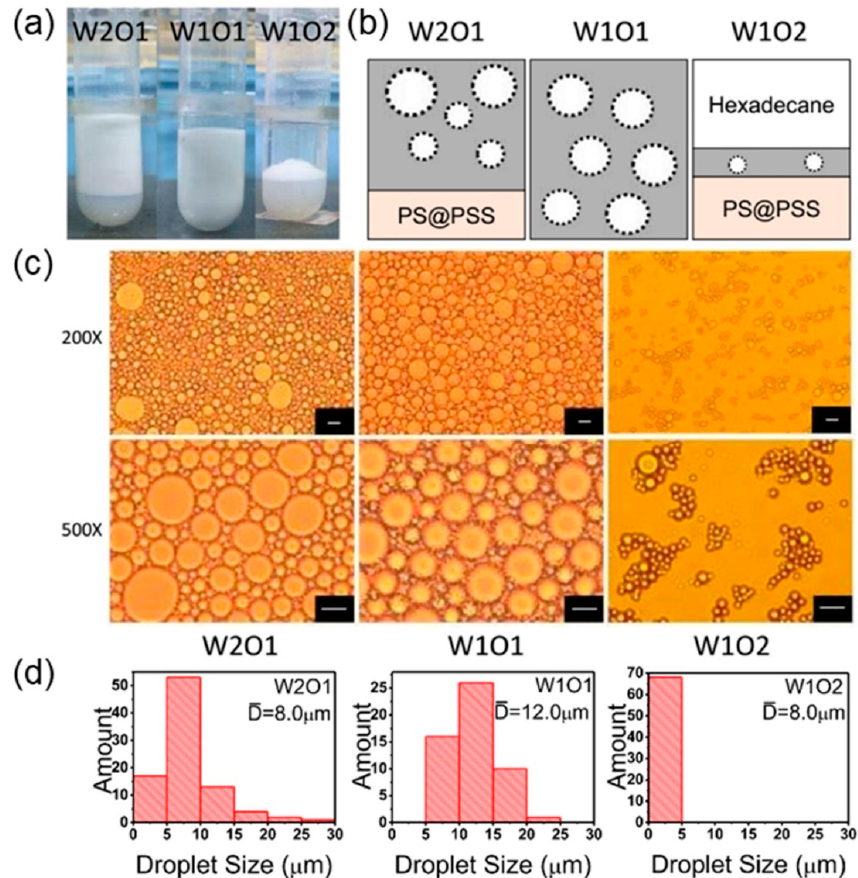
/ H 2 O Pickering emulsions stabilized by PS@PSS